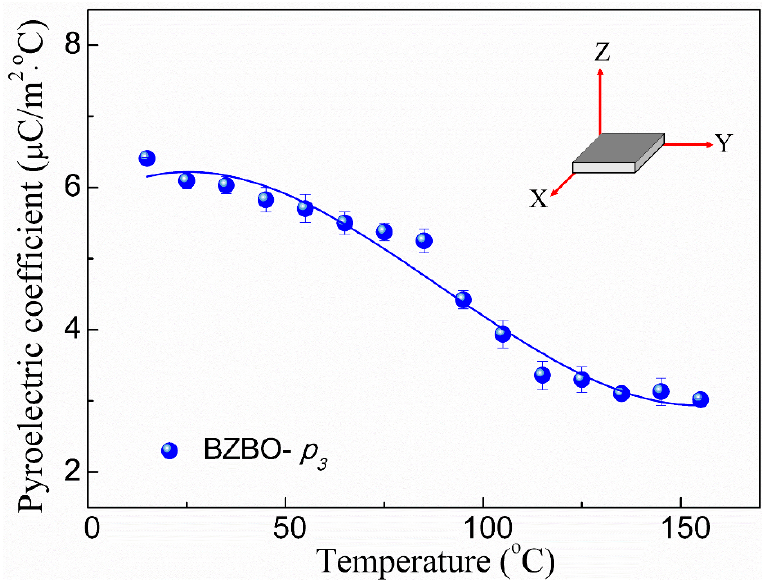
Figure 1. Temperature dependence of pyroelectric coefficient p 3 for BZBO crystals.